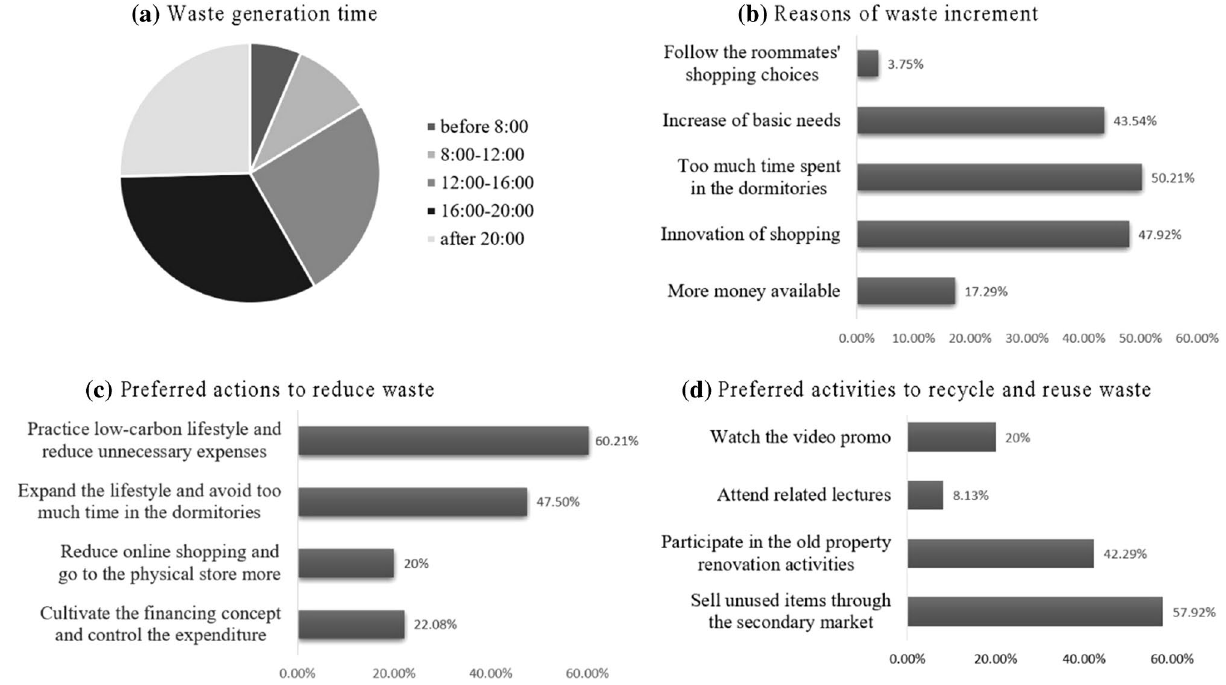
Figure 3. Results of personal choice factors. ( a ) Proportion of waste generation time period of respondents; ( b ) reasons of students generated more waste; ( c ) actions students preferred to take to reduce waste; ( d ) activities students preferred to take part in to recycle and reuse